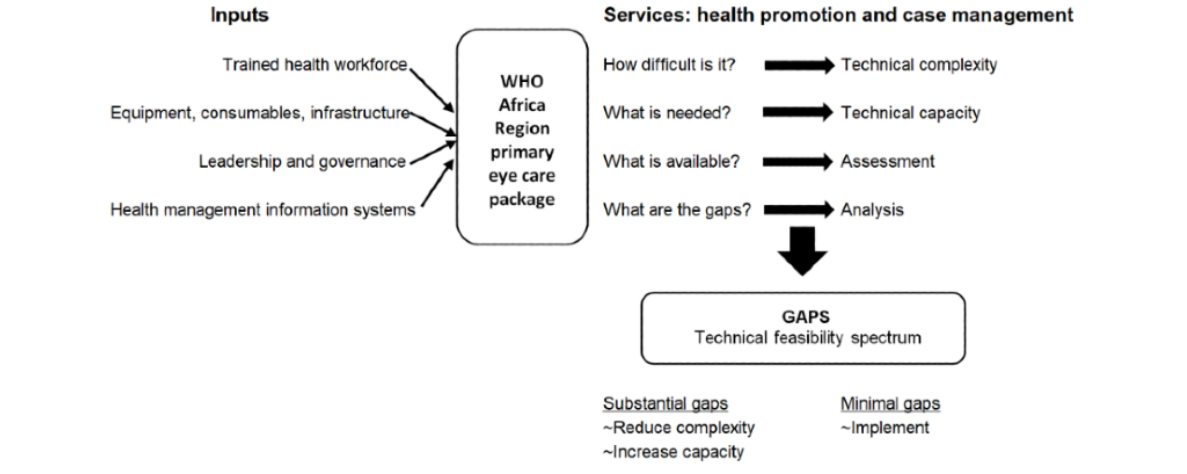
Figure 3. Theoretical framework for technical feasibility assessment derived from Gericke et al [27]. WHO: World Health